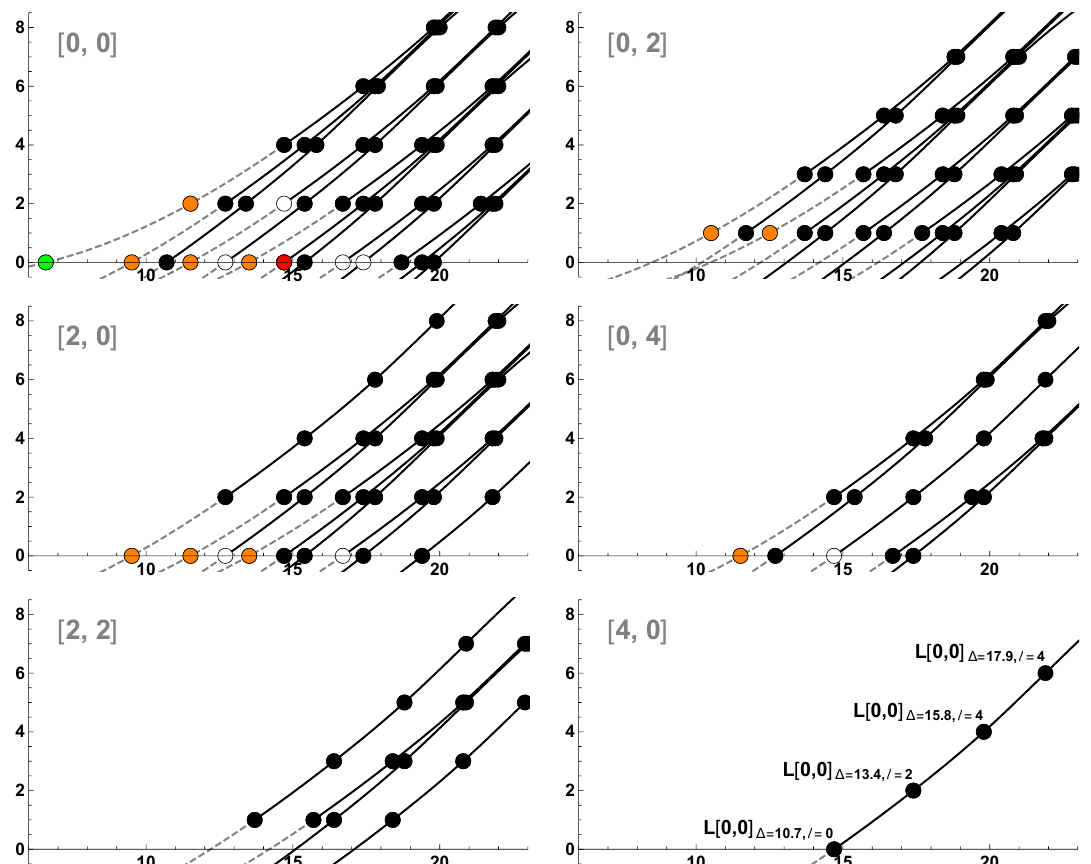
Figure 4. (∆ , ‘ ) planes: a randomly chosen L [0 , 0] ∆ ,‘ trajectory extending down to spin − 4 .